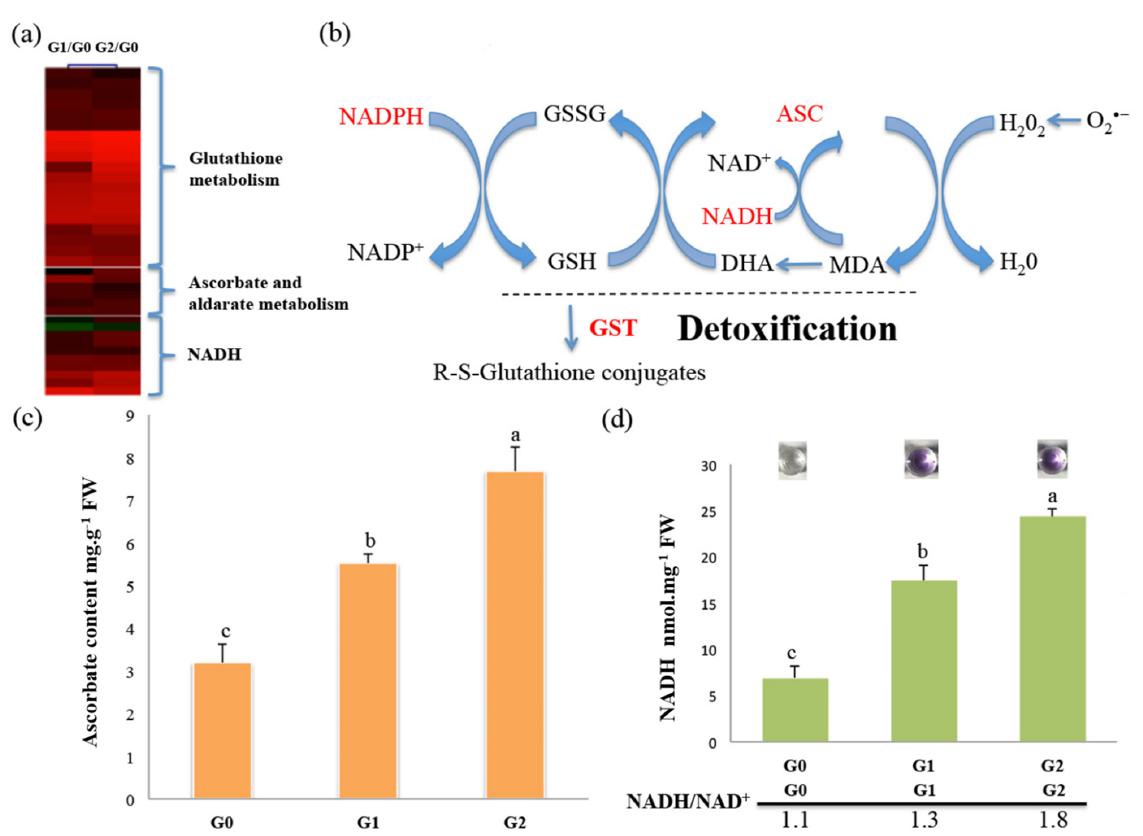
Figure 7. Protein landscape of the ASC–GSH cycle in C. spinifex . ( a ) Heat map visualization of DAPs involved in ROS scavenging in response to drought stress. ( b ) The ASC ‐ GSH cycle. ( c ) Ascorbate content of control roots (G0) and those subjected to drought treatment (G1 and G2). ( d ) Upper panel: NADH quantification. Lower panel: The ratio of NADH and NAD + . The small images show colorimetric reactions for NADH quantification corresponding to the bars below. Data are means ± standard deviations ( n = 3). Different superscript letters indicate significant differences between the treatments and the control ( p < 0.05). Abbreviations: ASC = ascorbate, DHA = dehydroascorbate, MDA = monodehydroascorbate, GR = glutathione reductase, GSH = glutathione, GSSG = oxidized glutathione, GST = glutathione S ‐ transferase. FW = fresh weight.